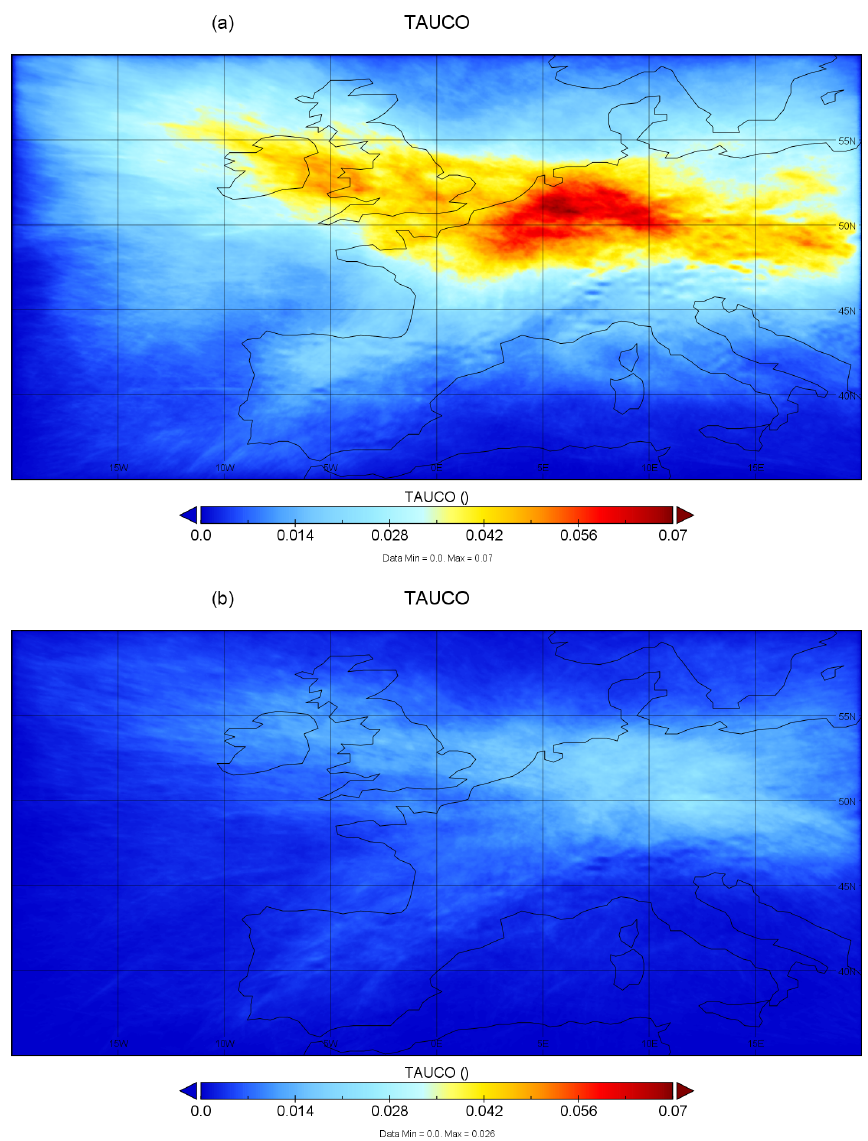
Figure 8. Mean optical thickness of contrails from March–August in 2019 (a) and difference 2019–2020 (b)